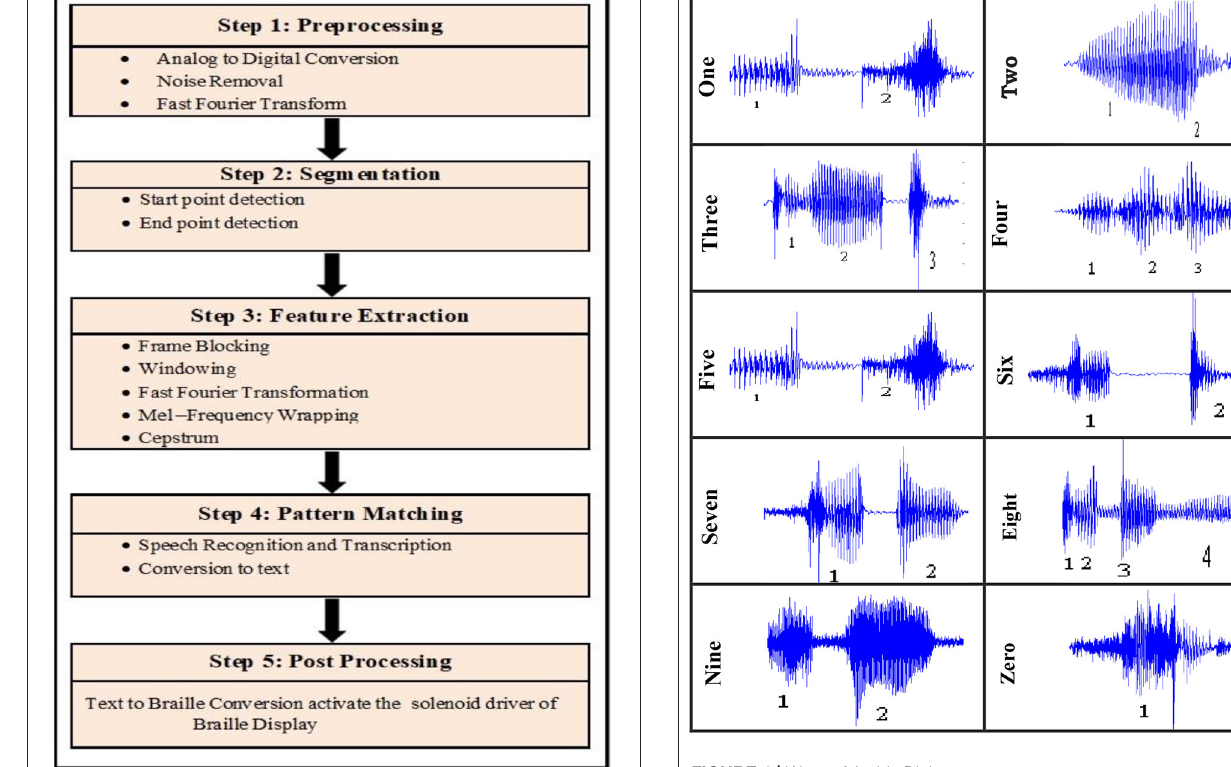
FIGURE 4 | Wave of Arabic